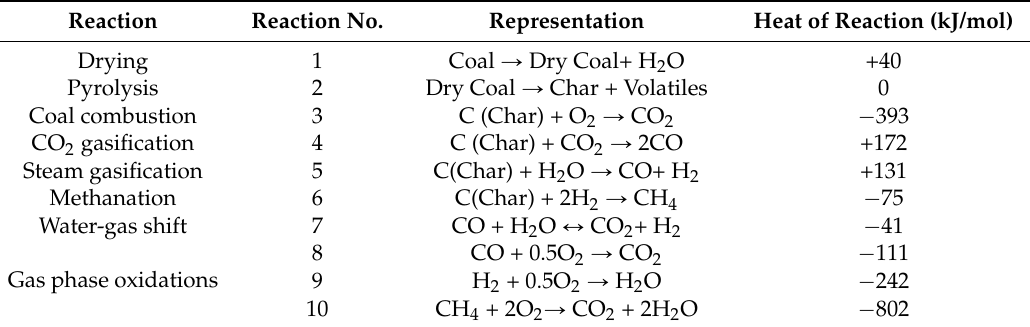
Table 1. Main reactions in the gasification